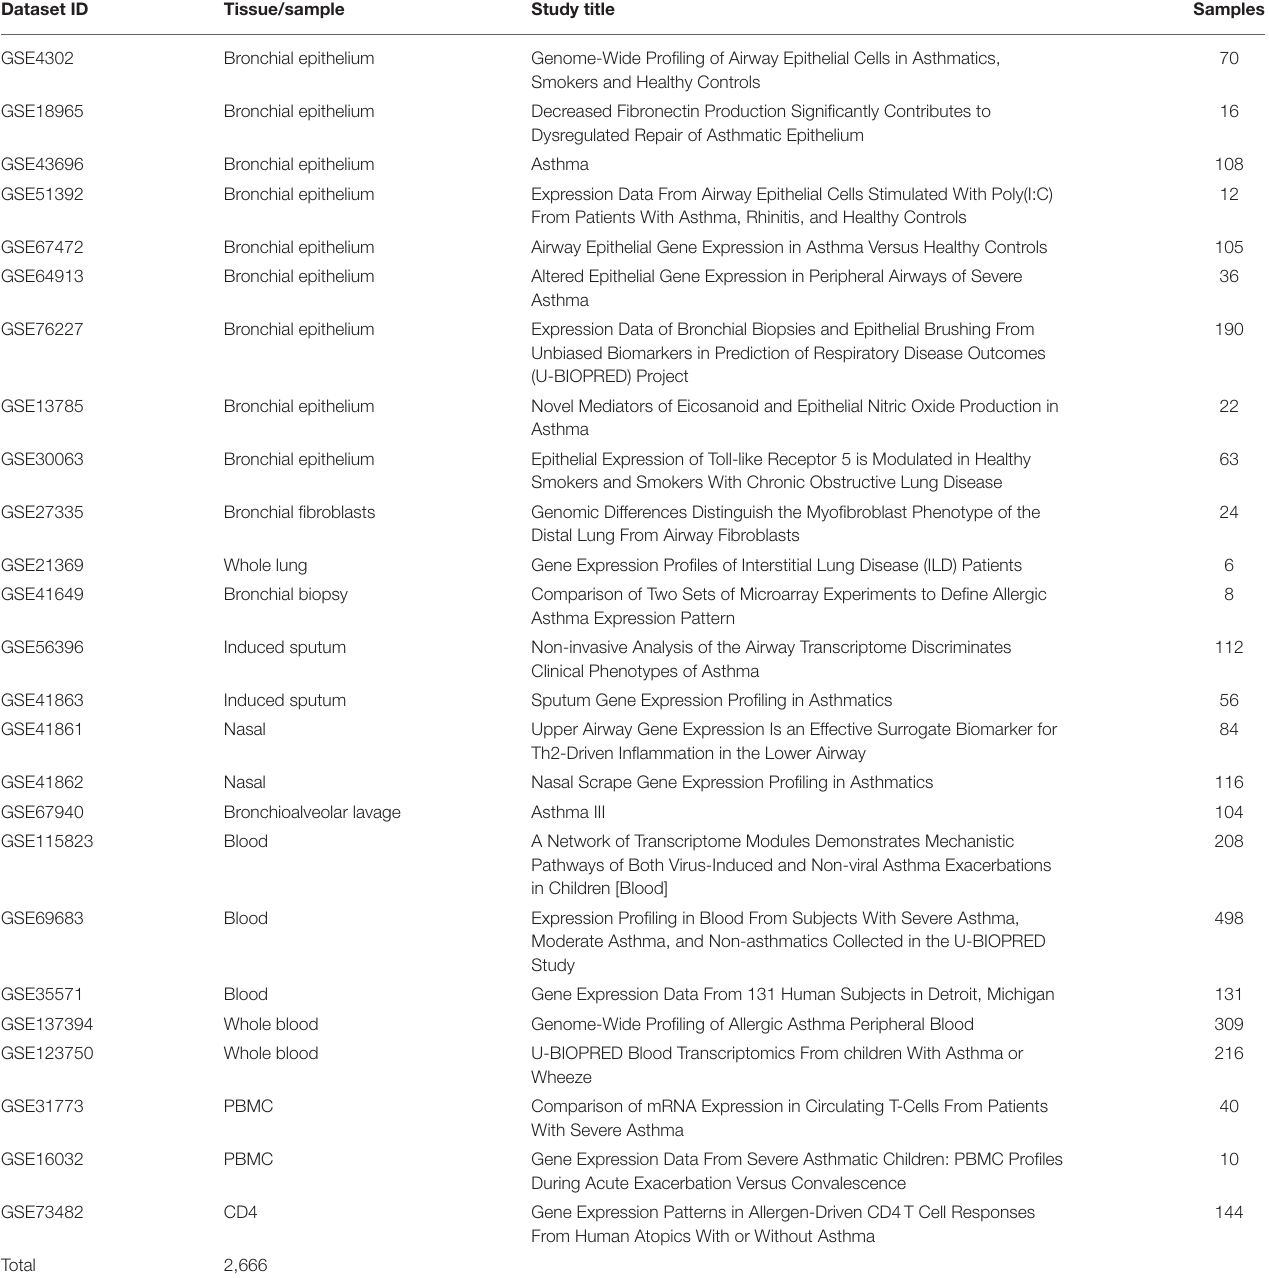
TABLE 3 | List of datasets extracted from GEO omnibus for the in silico analysis. Dataset